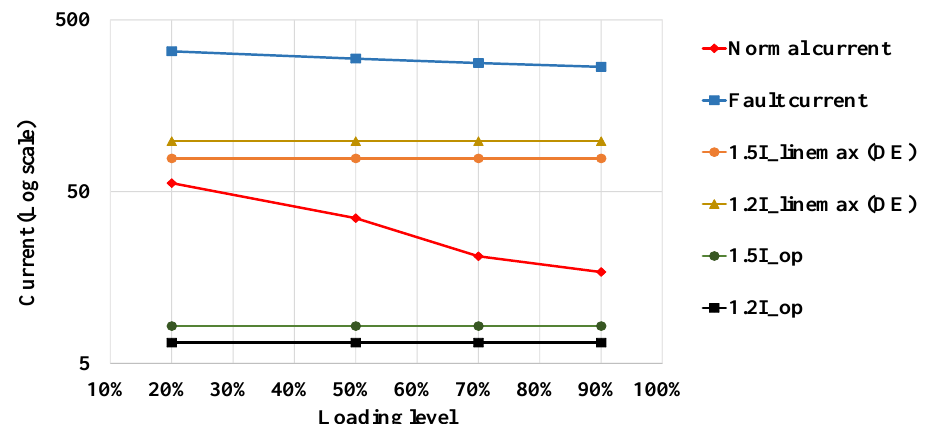
Figure 17. Fault condition under different loading levels with 95% of line and 1 Ω fault resistance.